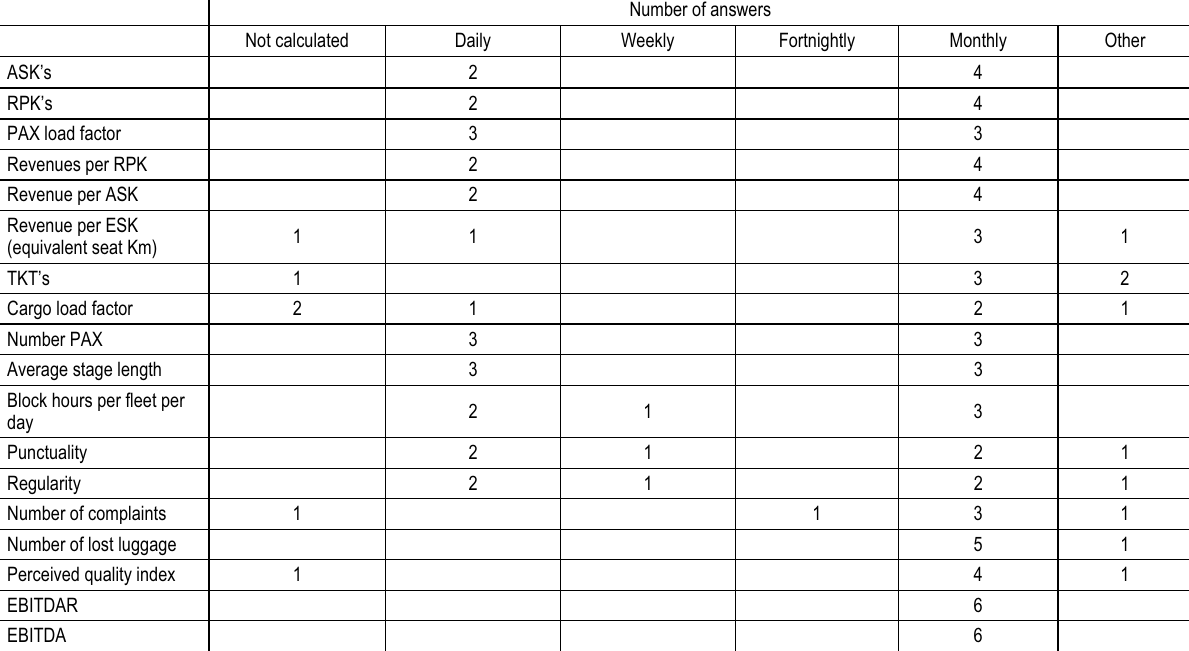
Table 11. Management indicators and detail in the operational